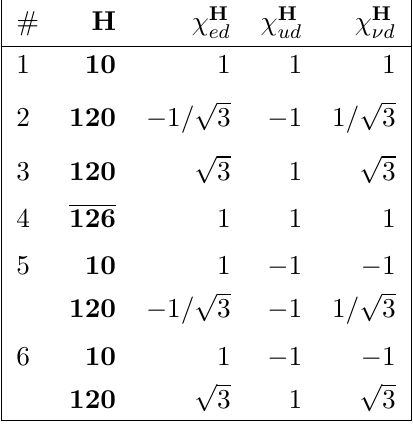
Table 4 . Examples of scenarios where (cid:31) H factors have (cid:12)xed numerical values. The # tags refer to cases of Higgs superpotentials in table 7, to be presented later. We give for each case the available representations H and associated (cid:31) H factors, as computed from tables 7 and 3 and eq. (2.19) . multiplet in SUSY) (cid:12)elds analyzed here. In this sense the scalar states correspond to the